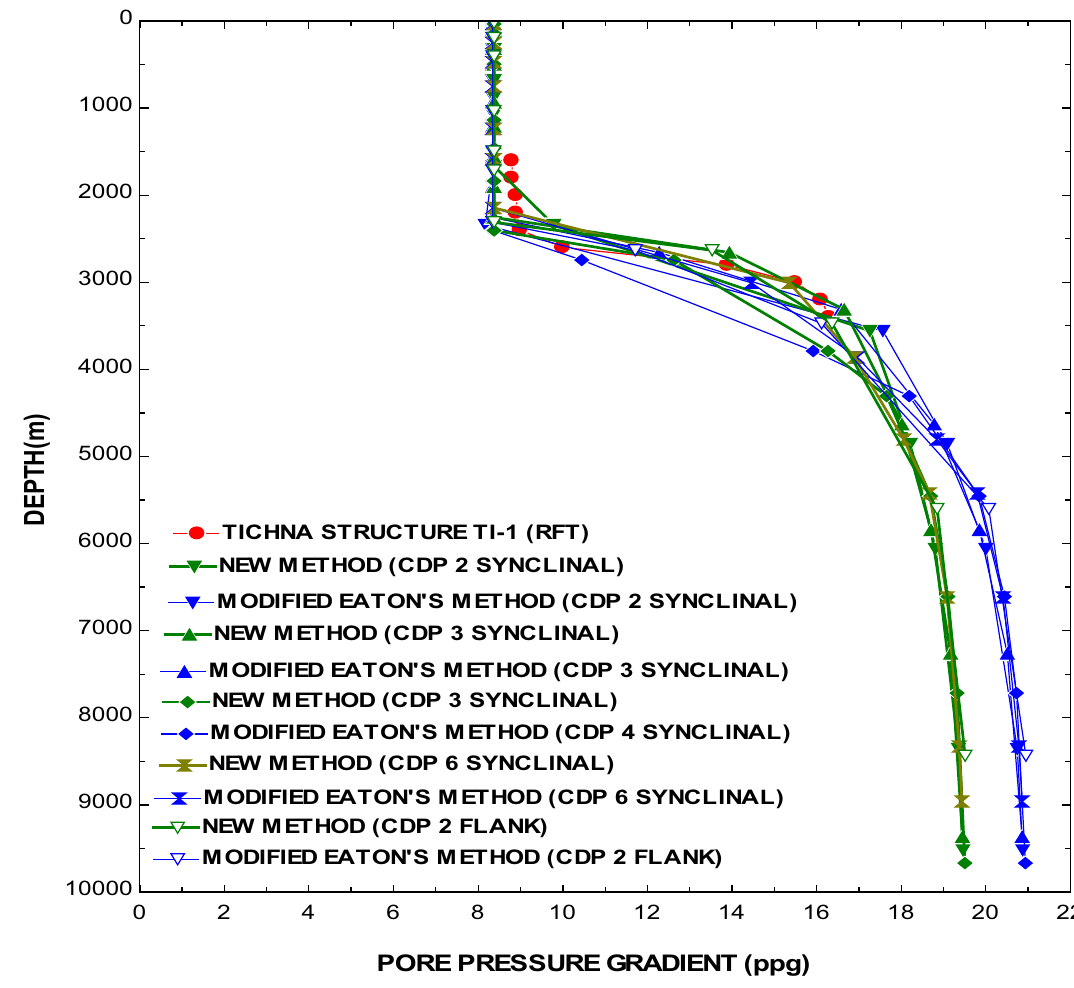
Fig. 8 RFT and predicted pore pressures by new method and modified Eaton’s method. (Tichna structure